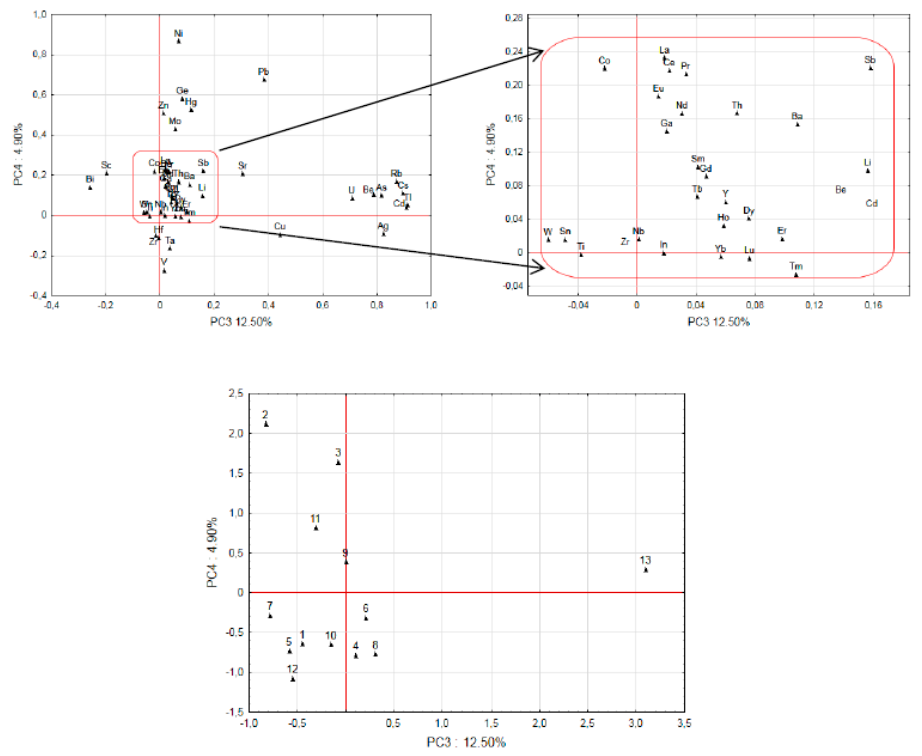
Figure 3. Plot of loadings based on the concentration of elements in fruiting bodies and projection of the element concentration levels in fruiting bodies collected in different sites set on the PC3 and PC4-plane, respectively (site id as in Figure 2).